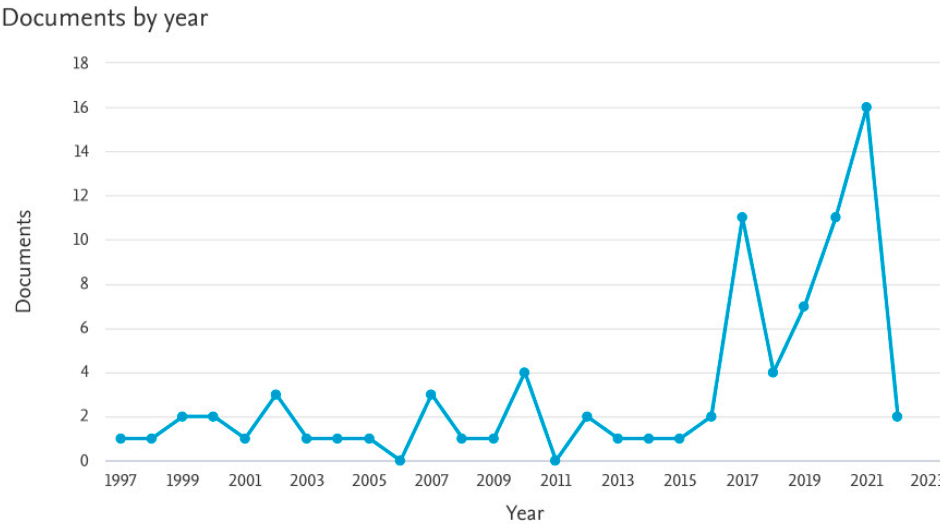
Figure 2. Trend of publication during the timeframe (Scopus source).